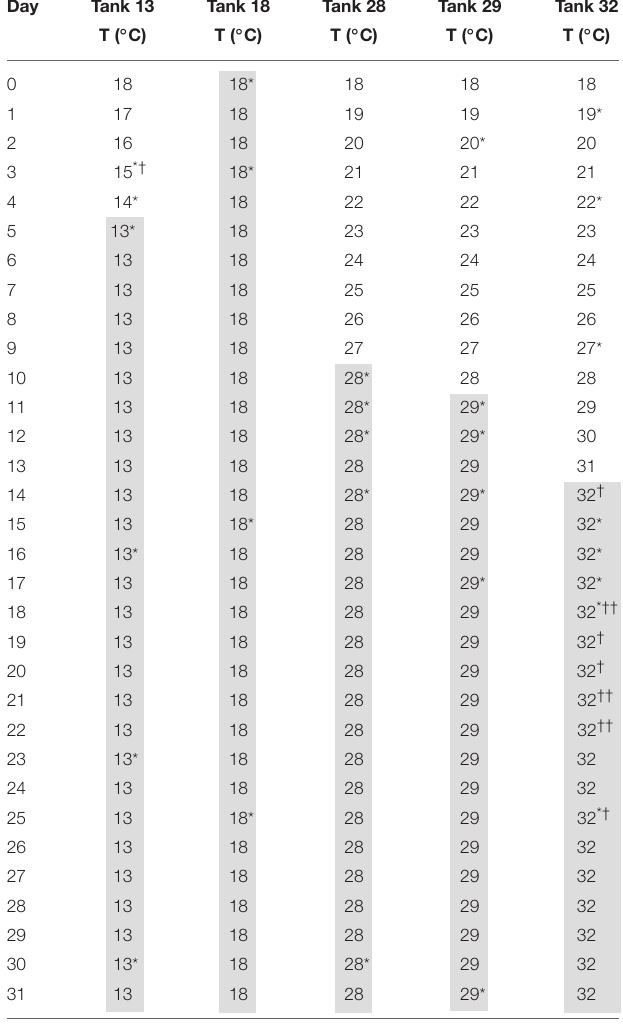
Each tank was named after the temperature treatment (indicated as gray areas). One asterisk means that three corals were collected from that tank for analyses. One symbol † appears for each coral that died in that tank that